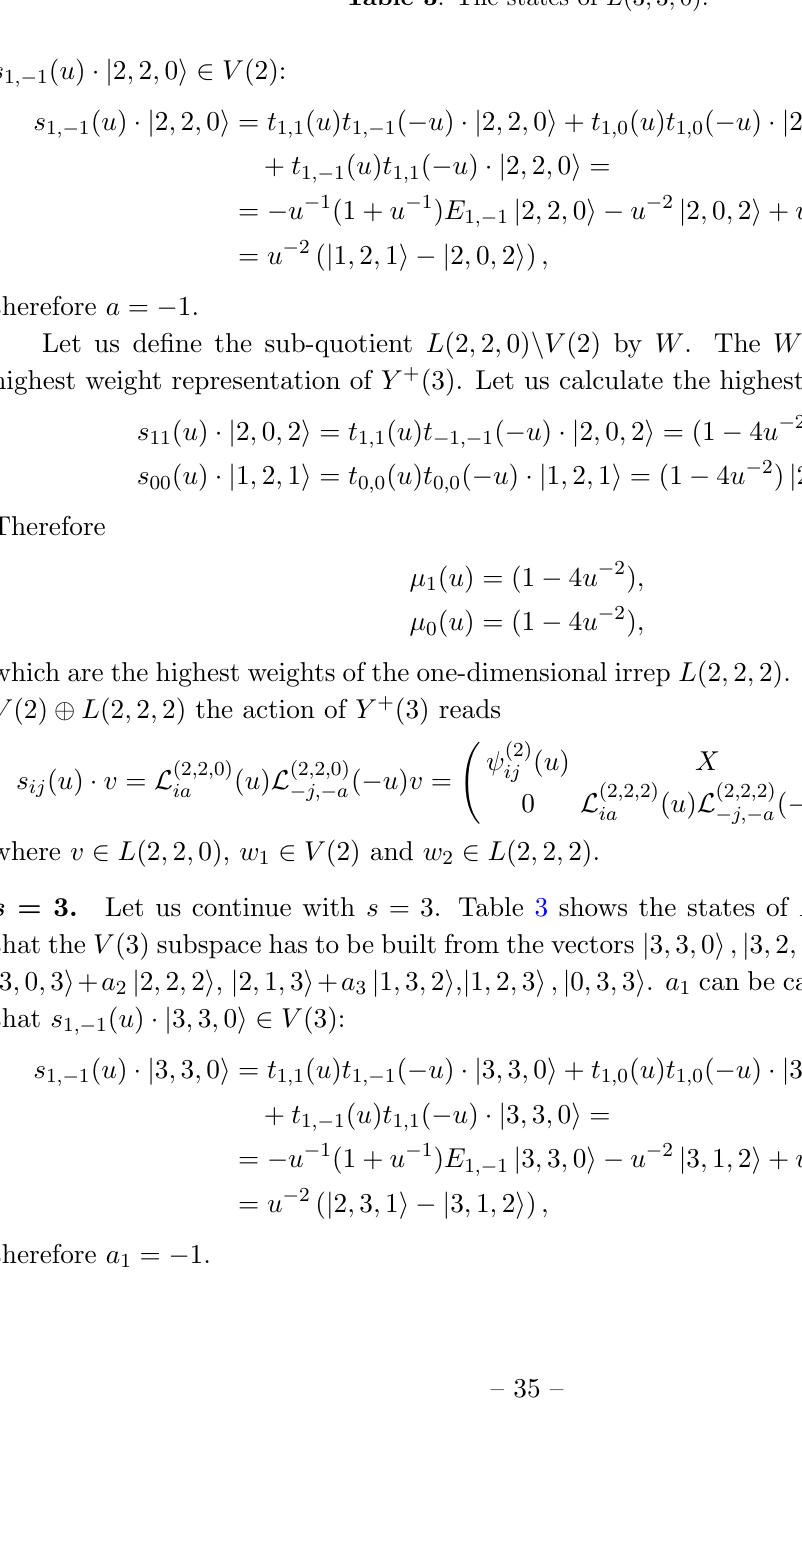
Table 3 . The states of L (3 ; 3 ;